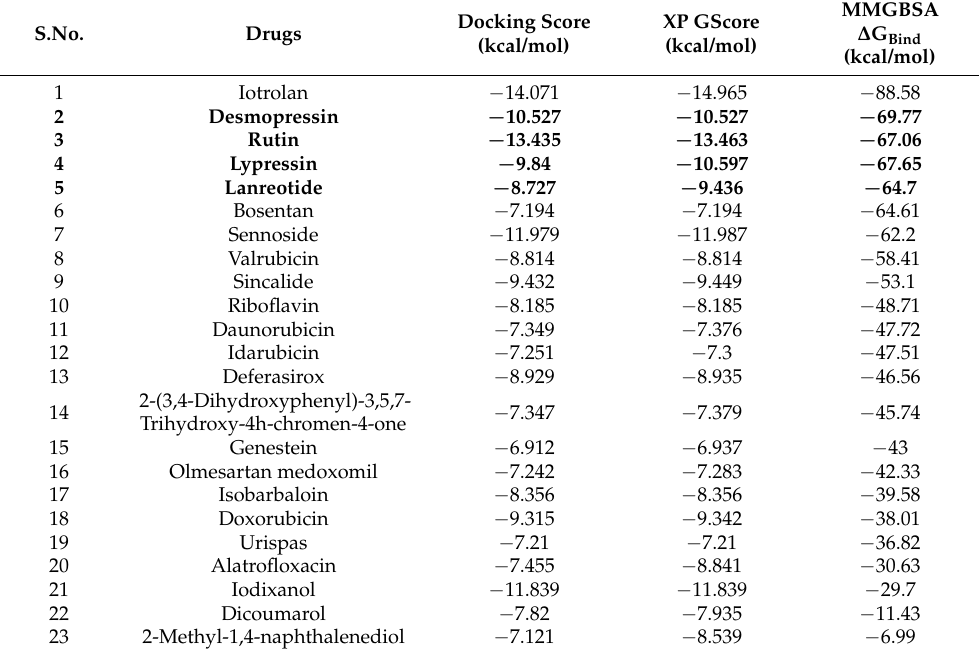
Table 2. Binding scores of the top four screened drug compounds against DENV